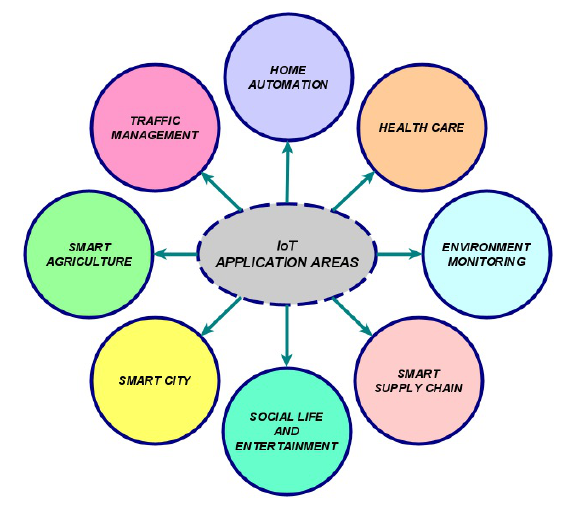
Figure 1. Application areas of